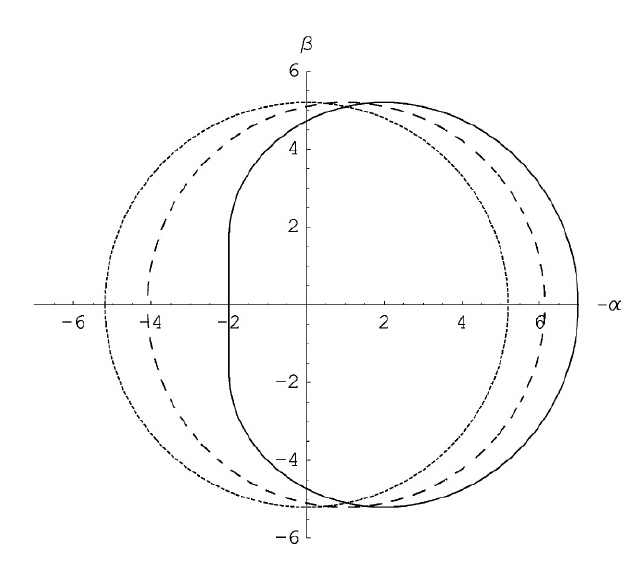
Figure 9. Retro-lensing images of a source by a Schwarzschild black hole (dotted circle), a Kerr black hole with spin parameter a = 0.5 (dashed line) and a maximally spinning black hole with a = 1 (continuous line). The line of sight of the observer is perpendicular to the spin axis of the black hole.